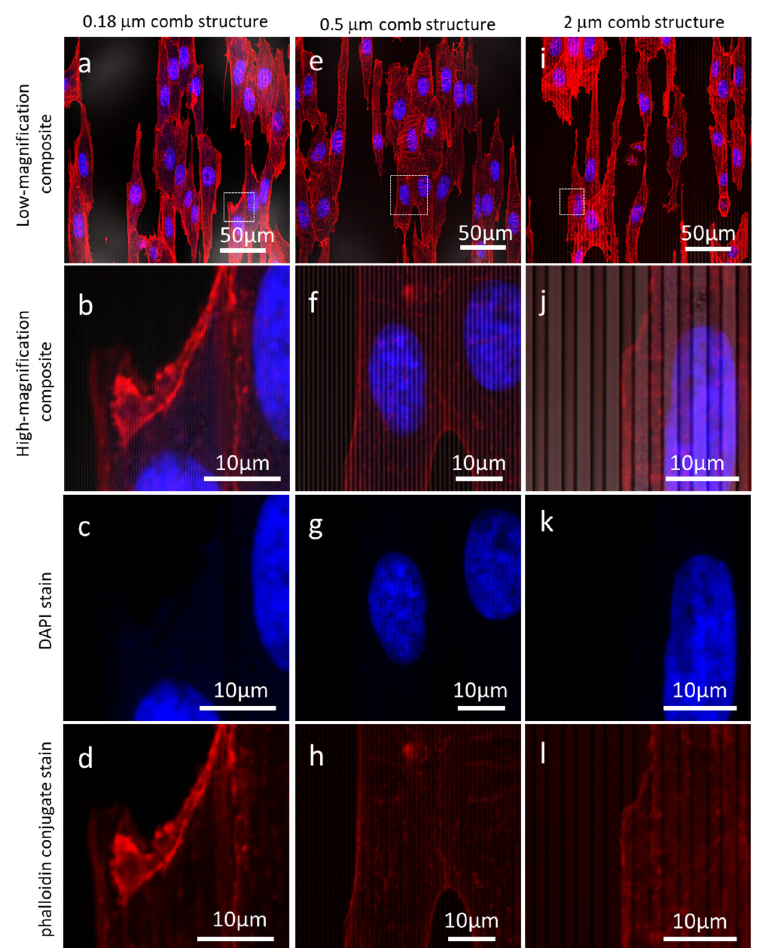
Figure 3. Low- and high-magnification fluorescence confocal micrographs of cells adhered to 0.18 µ m ( a – d ), 0.5 µ m ( e – h ), and 2 µ m comb structures ( i – l ). The nuclei (blue), actin microfilaments (red) aligned to the pattern axes. Cells were incubated for 24 h with a concentration of ~5 × 10 5 cells/mL.